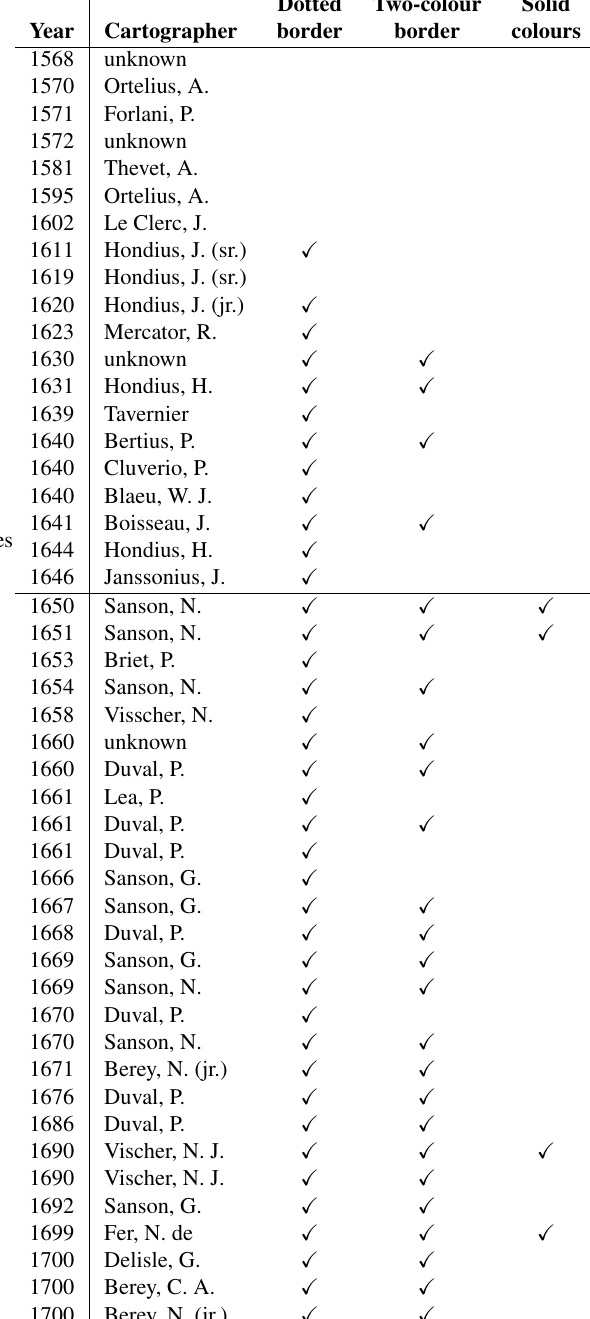
Table 1: The evolution of border representations in European ‘po- litical’